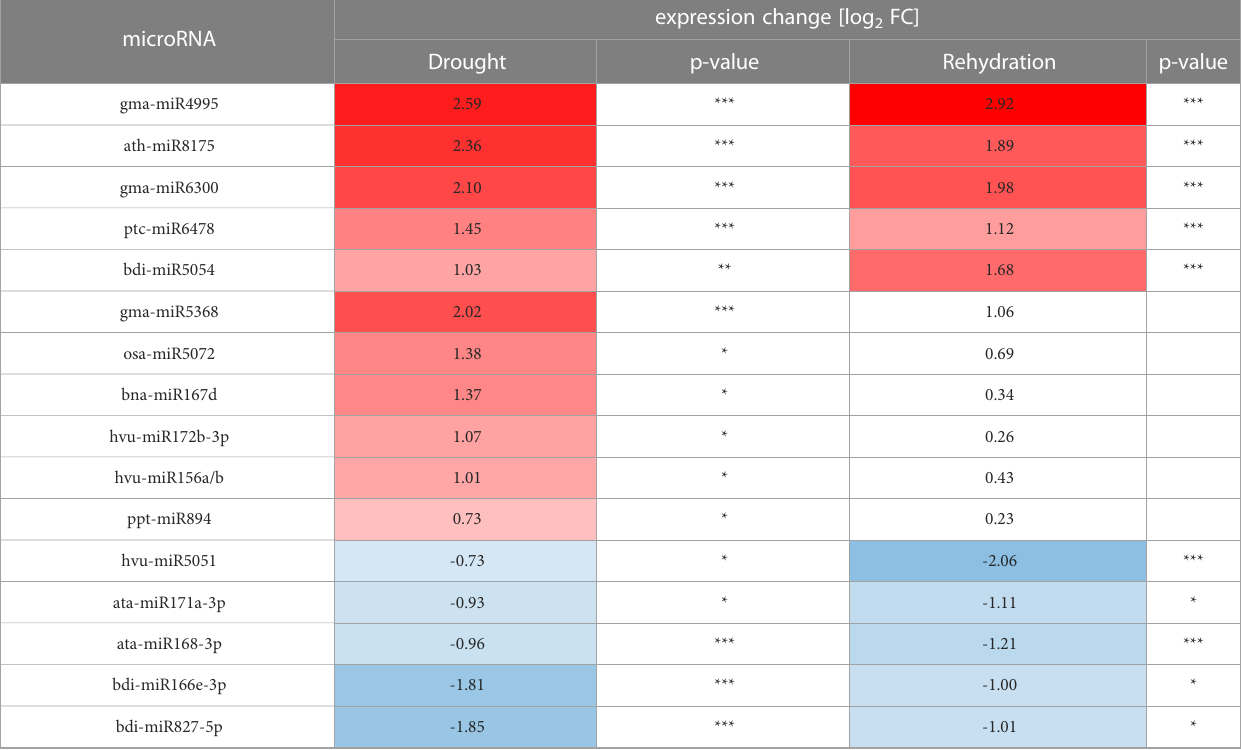
TABLE 2 MicroRNAs downregulated or upregulated in drought and/or rehydration